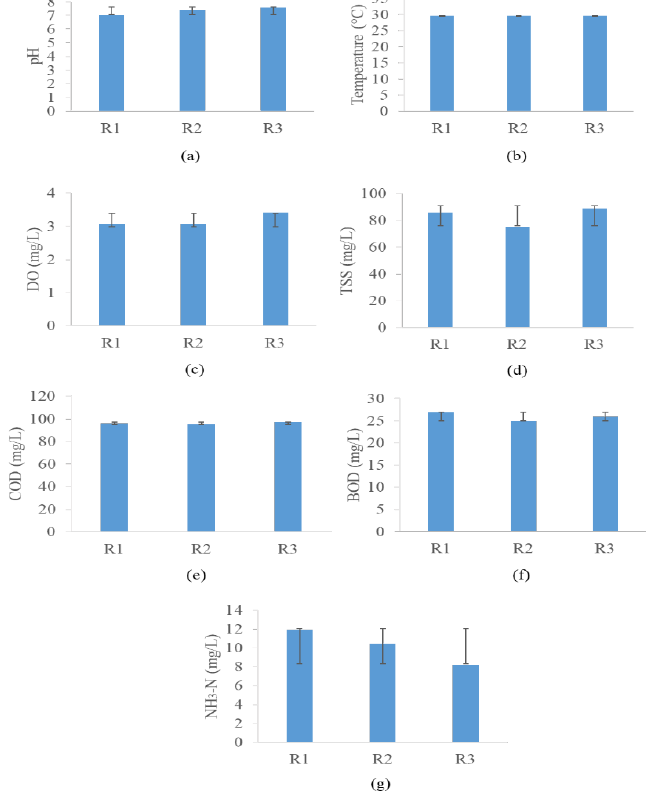
Figure 2. The initial parameters reading of sewage wastewater samples for ( a ) pH, ( b ) temperature, ( c ) DO, ( d ) TSS, ( e ) COD, ( f ) BOD and ( g ) NH 3 -N.